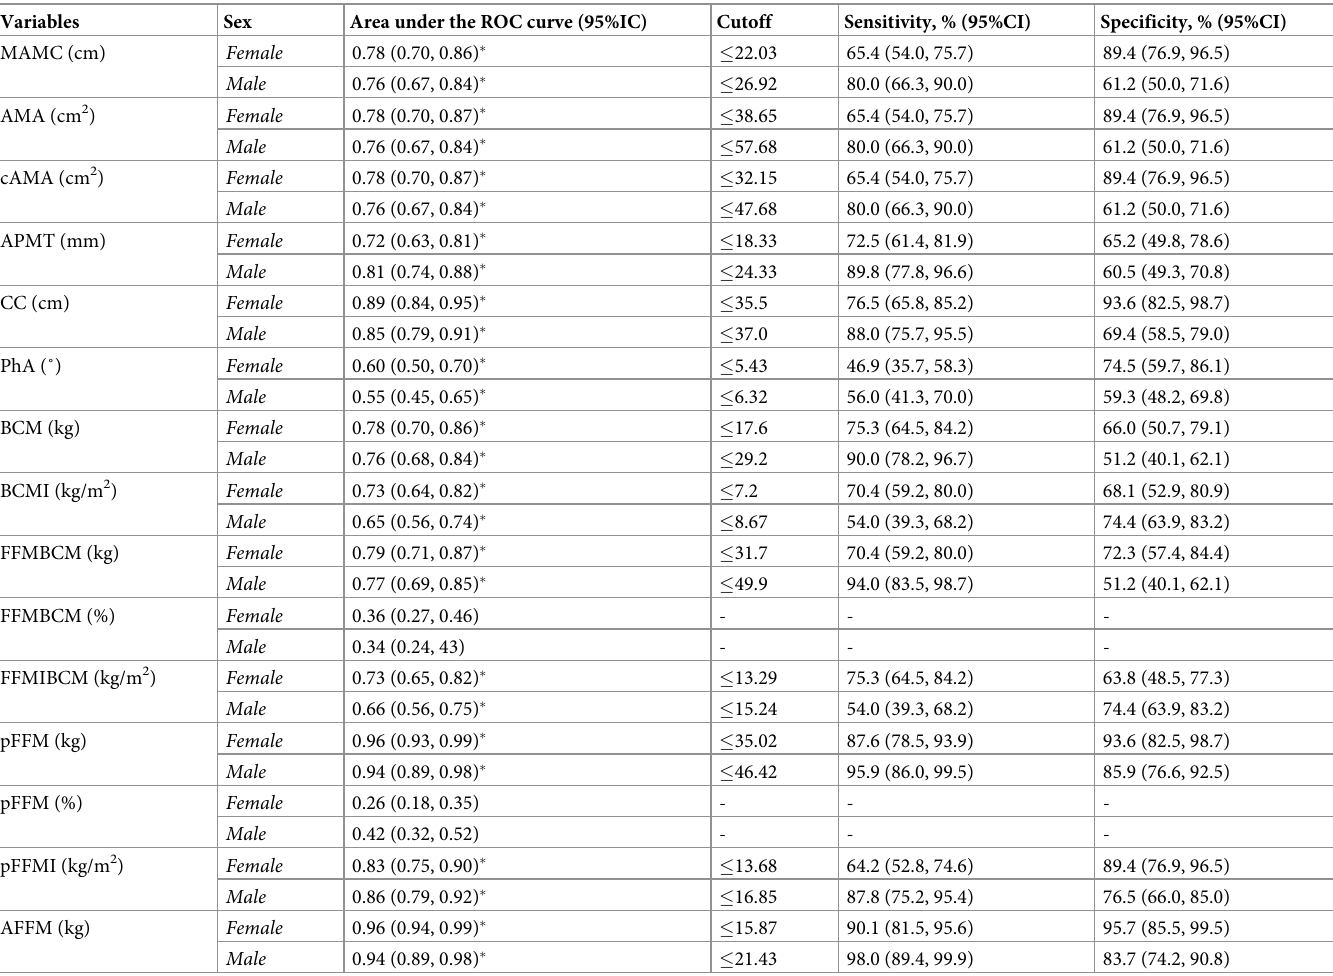
Table 3. Area under the ROC curve, cutoff, sensitivity, and specificity of the muscle measures/indexes to identify low muscle mass 1 .